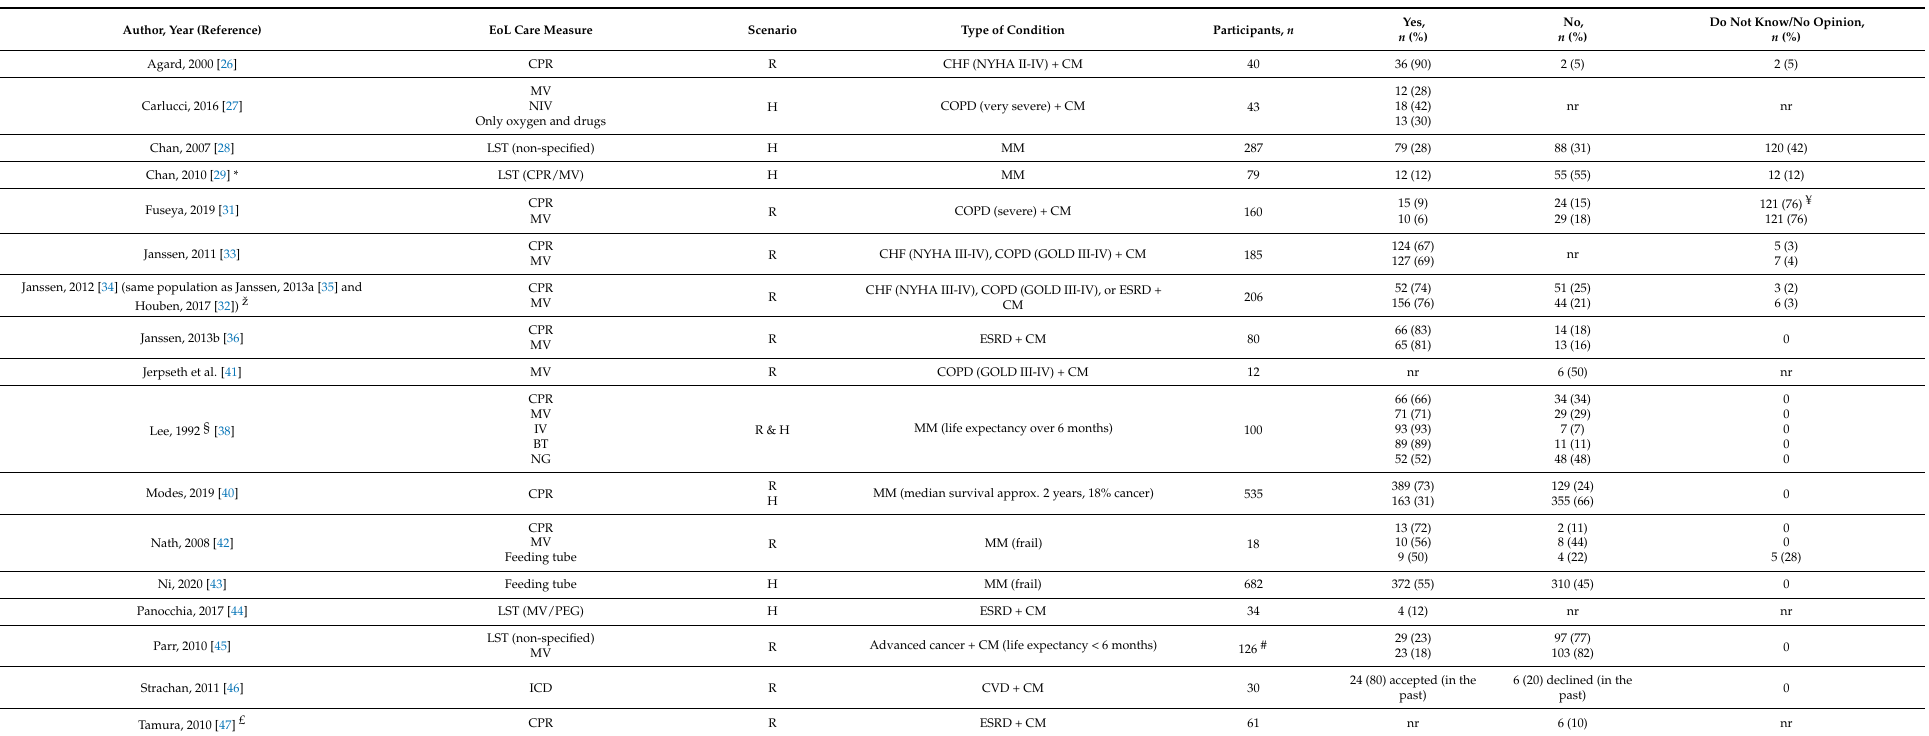
Table 3. Willingness to receive